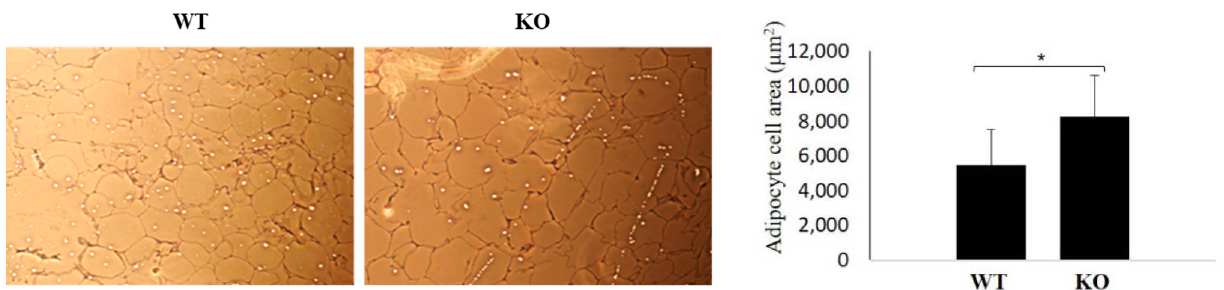
Figure 6. Adipocytes in KO and WT mice. Adipocytes were significantly larger in KO mice than in WT mice. Brightfield imaging was done with a Nikon microscope at × 10 magnification. * p < 3.51 × 10 9 .